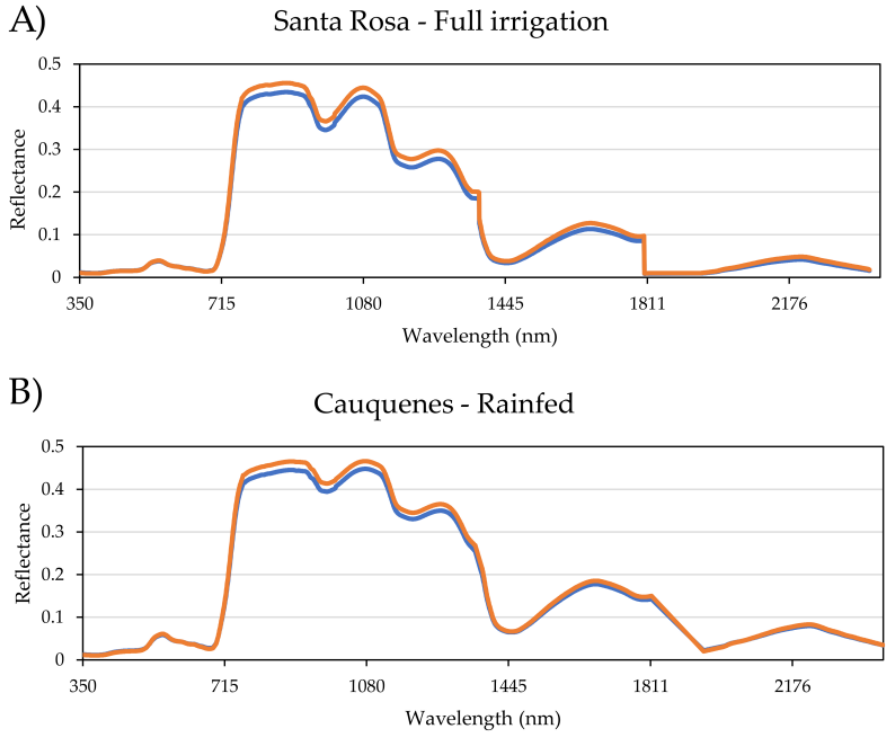
Figure 2. The average of spectral curves for each genetically differentiated group (Q1, in blue, and Q2, in orange) in the environments Santa Rosa ( A ) and Cauquenes ( B ).